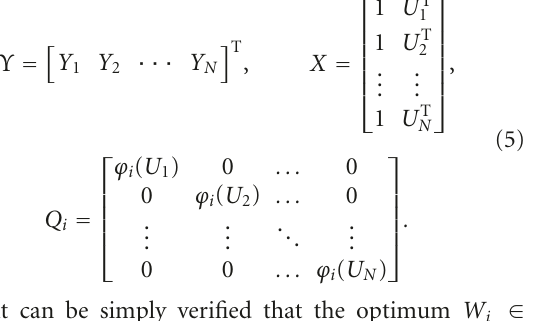
Figure 1: Local linear neurofuzzy